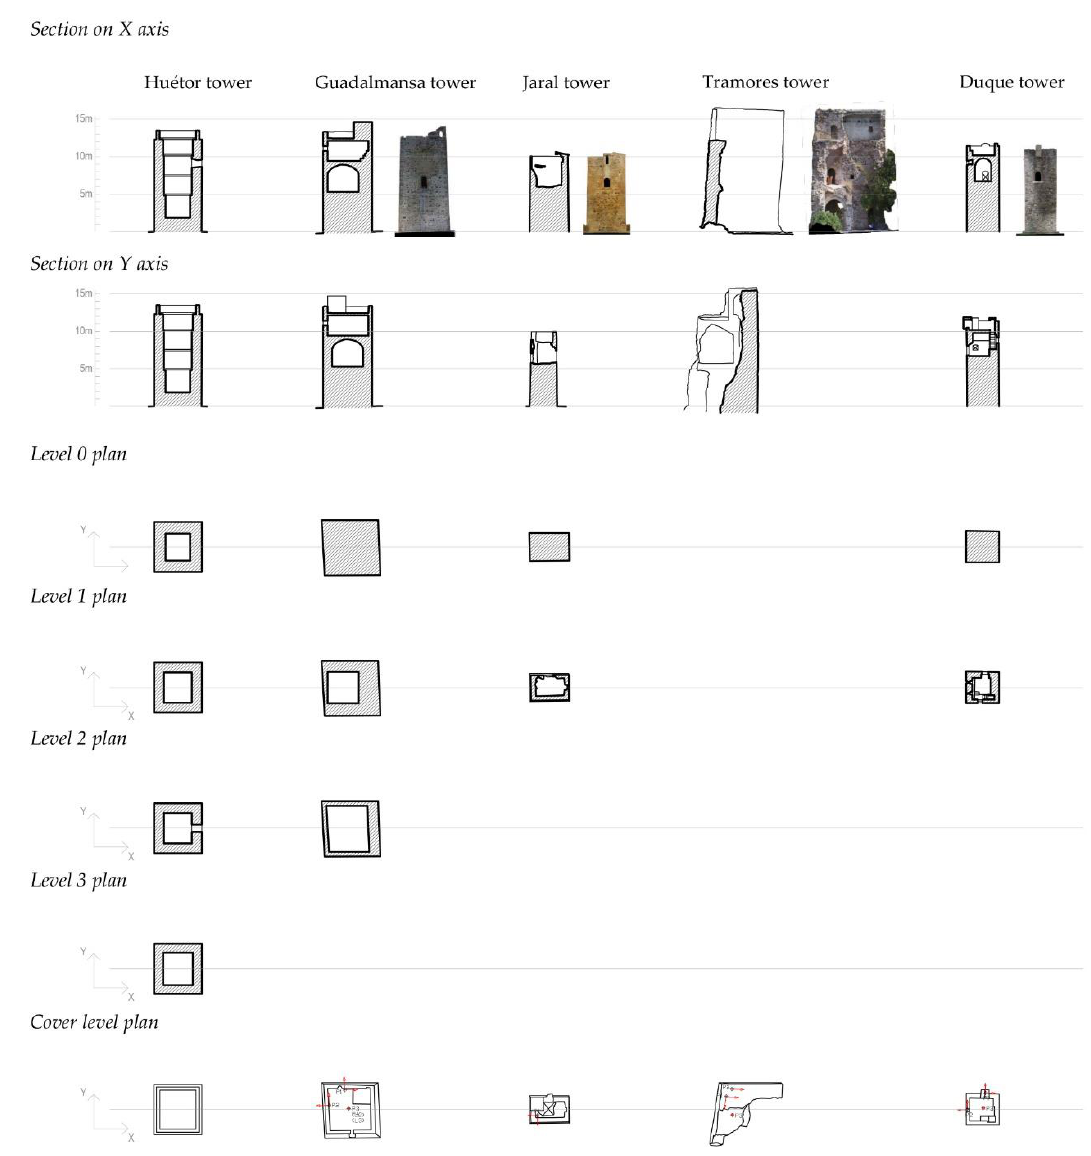
Figure 2. Description of elevations and plans of towers in this study .